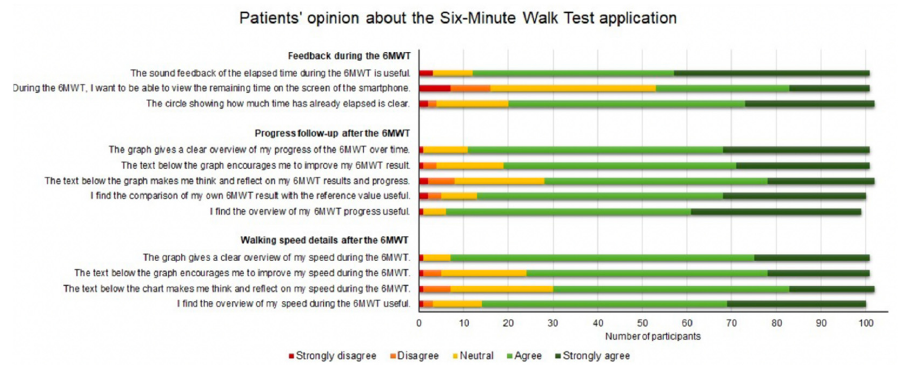
Figure 10. Cardiovascular disease patients’ opinion about the mockups of a six-minute walk test application. 6MWT: six-minute walk test.